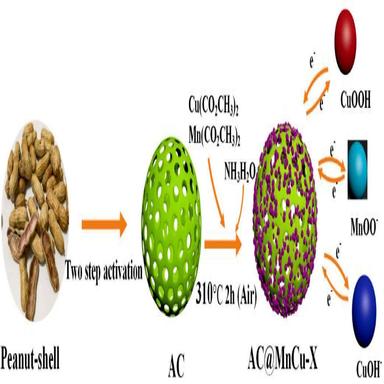
Schematic diagram of the synthesis route of Mn/Cu bimetal-decorated biomass porous carbons.